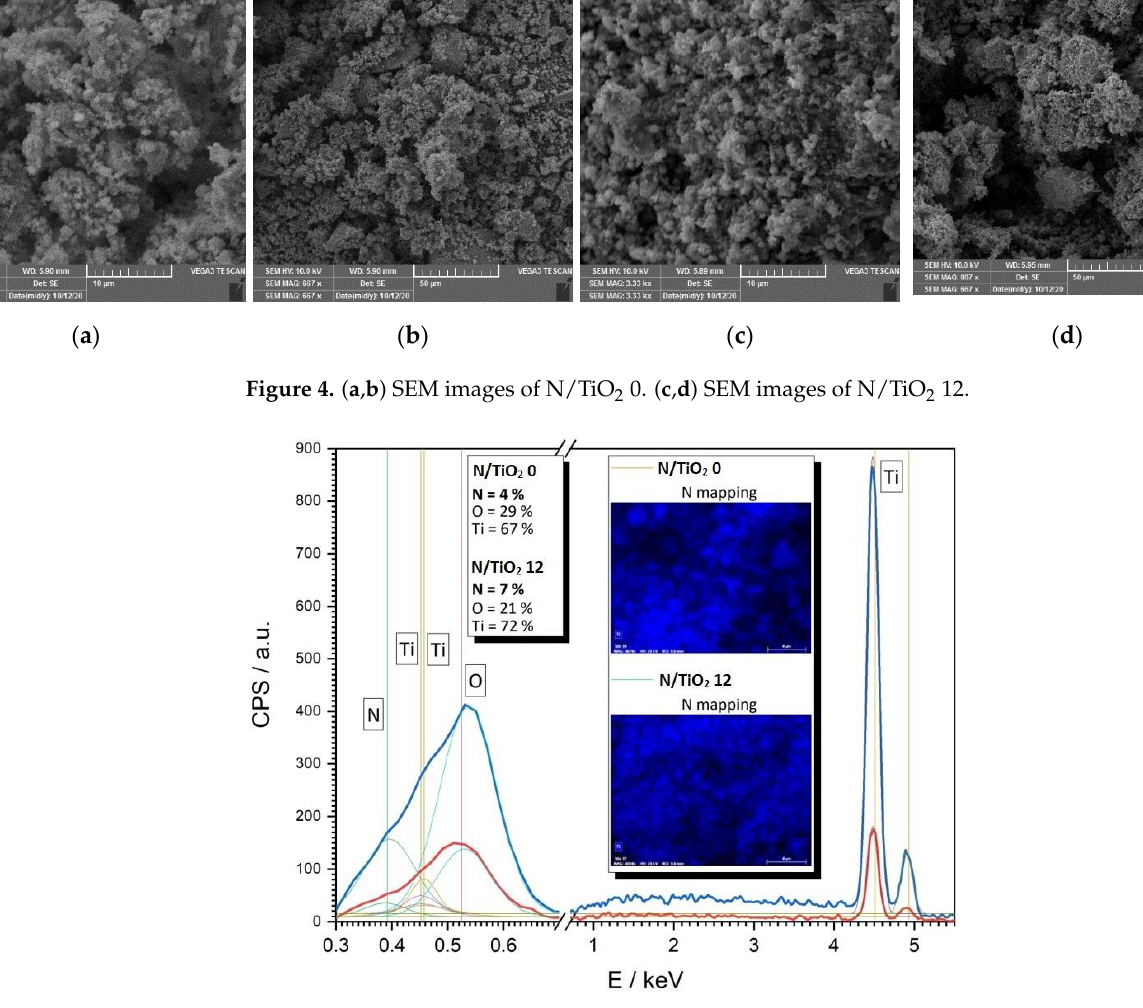
Figure 5. The fit of the EDS spectra for the N/TiO 2 0 (4 atomic % of N) and N/TiO 2 12 (7 atomic % of N). Inset: EDS mapping for the TiO 2 materials synthesized at 0 and 12 N/Ti molar ratios.